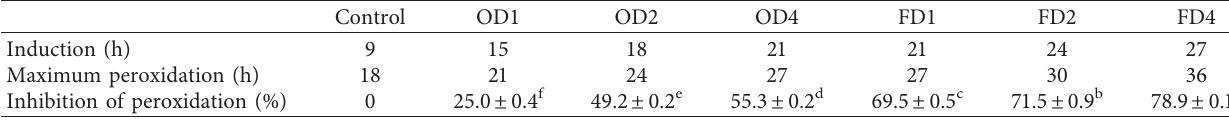
Table 2: Kinetics characteristics of peroxidation of soybean oil in microcapsules with different drying methods and shell: core ratios. Control OD1 Maximum peroxidation (h) Results are expressed as mean ± standard deviation ( n � 3). Means in the same row with different letters are significantly different based on Duncan multiple range test. Table 3: Percent of curcumin released in different simulated di- gestive fluids. Without pepsin With pepsin SGF (%)